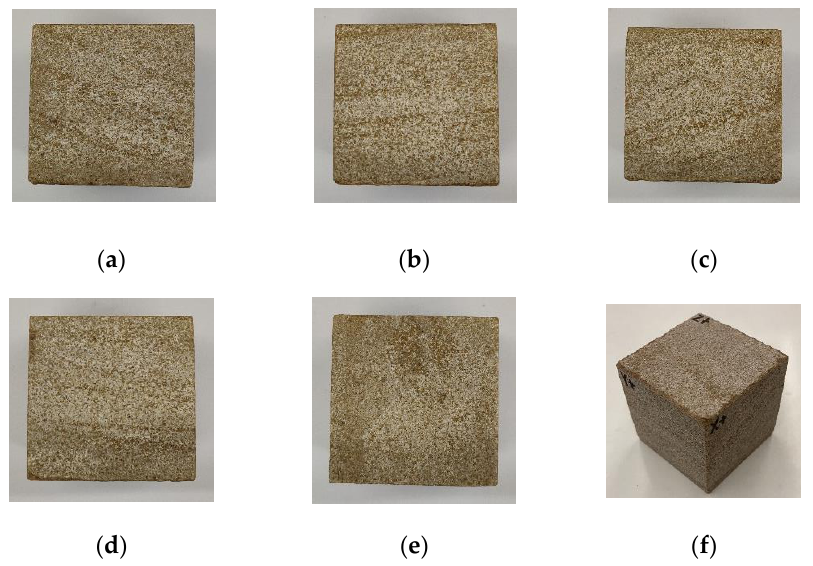
Figure 1. Cores used in our experiment ( a – e ) are the 4 side and top photos of the cubic core, ( f ) is the full-view photo of the cubic core.